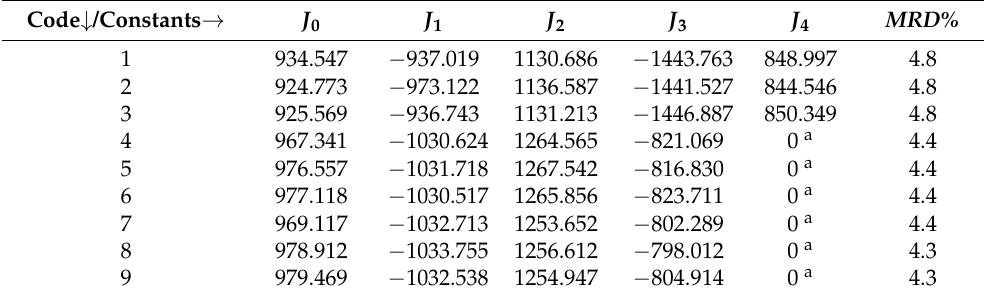
Table 3. Effects of different number of the J terms on the fitness of solubility data of sulfadiazine in acetonitrile + methanol mixtures expressed in different concentration units and the obtained mean relative